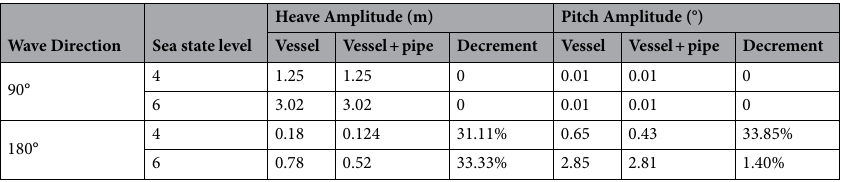
Table 4. The amplitude of mining vessel motion under different conditions.